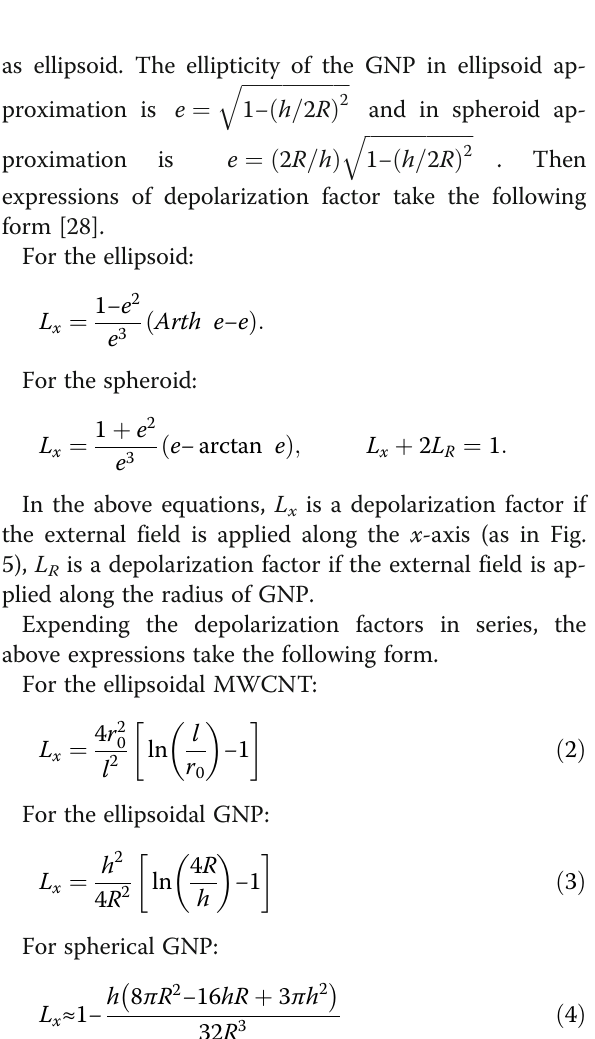
ε (cid:3) m ; p ¼ ε m ; p − j σ m ; p ε σ polarizability, m , p , m , p are dielectric ω , and constant and conductivity of the medium and particle, ω = 2 π f , f — electric field frequency.